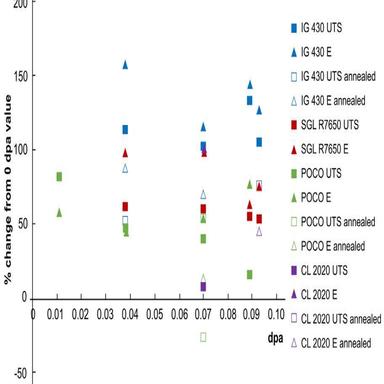
Mechanical property change of fine grain graphite candidates in BLIP experiment. Figure adapted from.